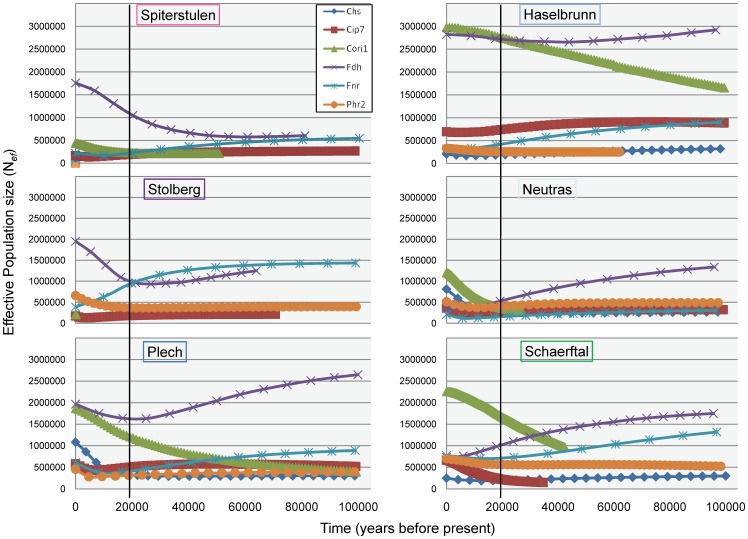
Bayesian skyline plots (BSP) showing estimates of effective population sizes (Nef) into the past for each of 6 loci.Each locus is represented by a separate line on each graph. Time (in years before the present) is on the x-axes and Nef is on the y-axes. Black lines indicate the approximate time of the LGM at 20,000 years before present.